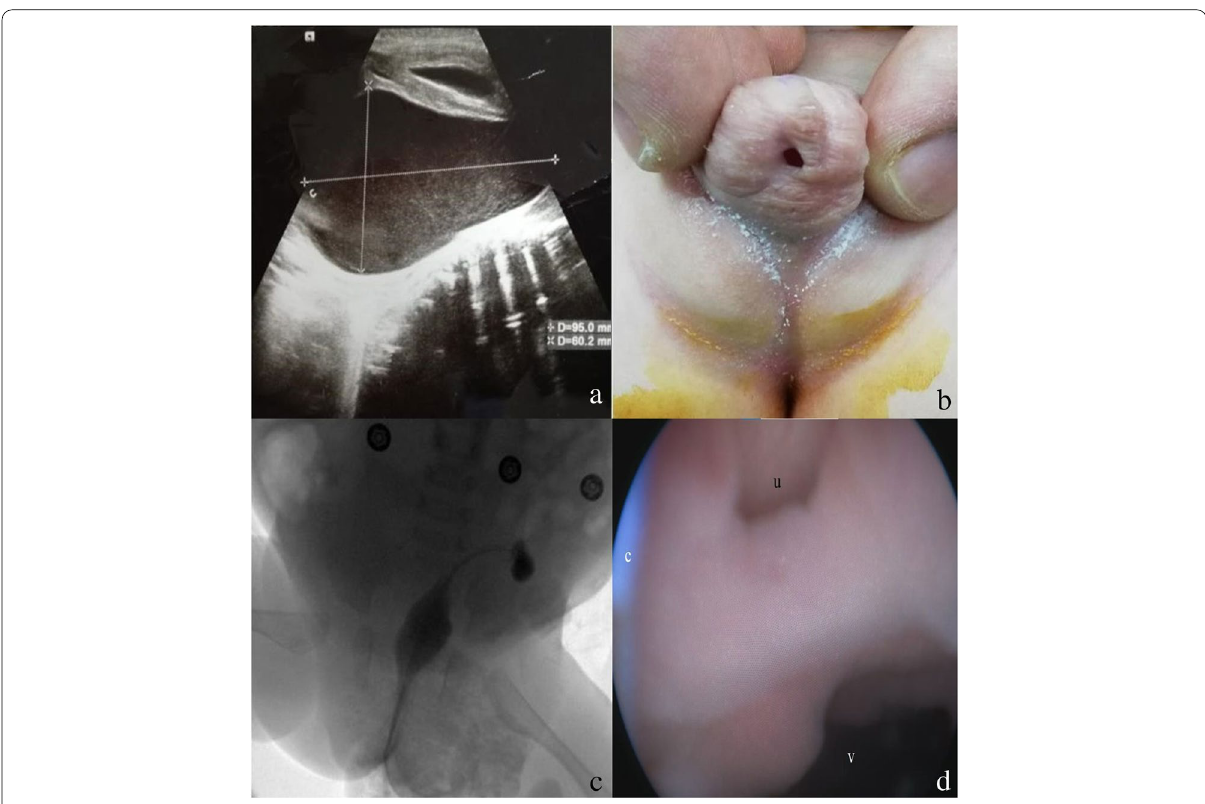
Fig. 1 a Hydrocolpos ultrasound image. b Hypertrophic phallus and external UGS meatus. c Genitography. d Rectoscopy image ( c , catheter; v , vagina; u ,